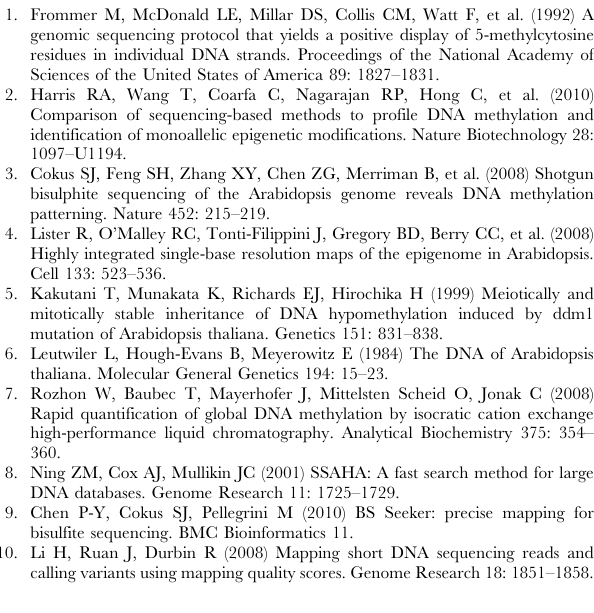
Table S21 Comparison with simulated data (Arabidop- sis, Human). (XLS) Table S22 Annotation of validated